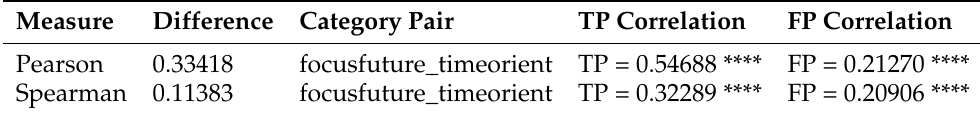
Table 50. Focusfuture and Time orientated language in High.